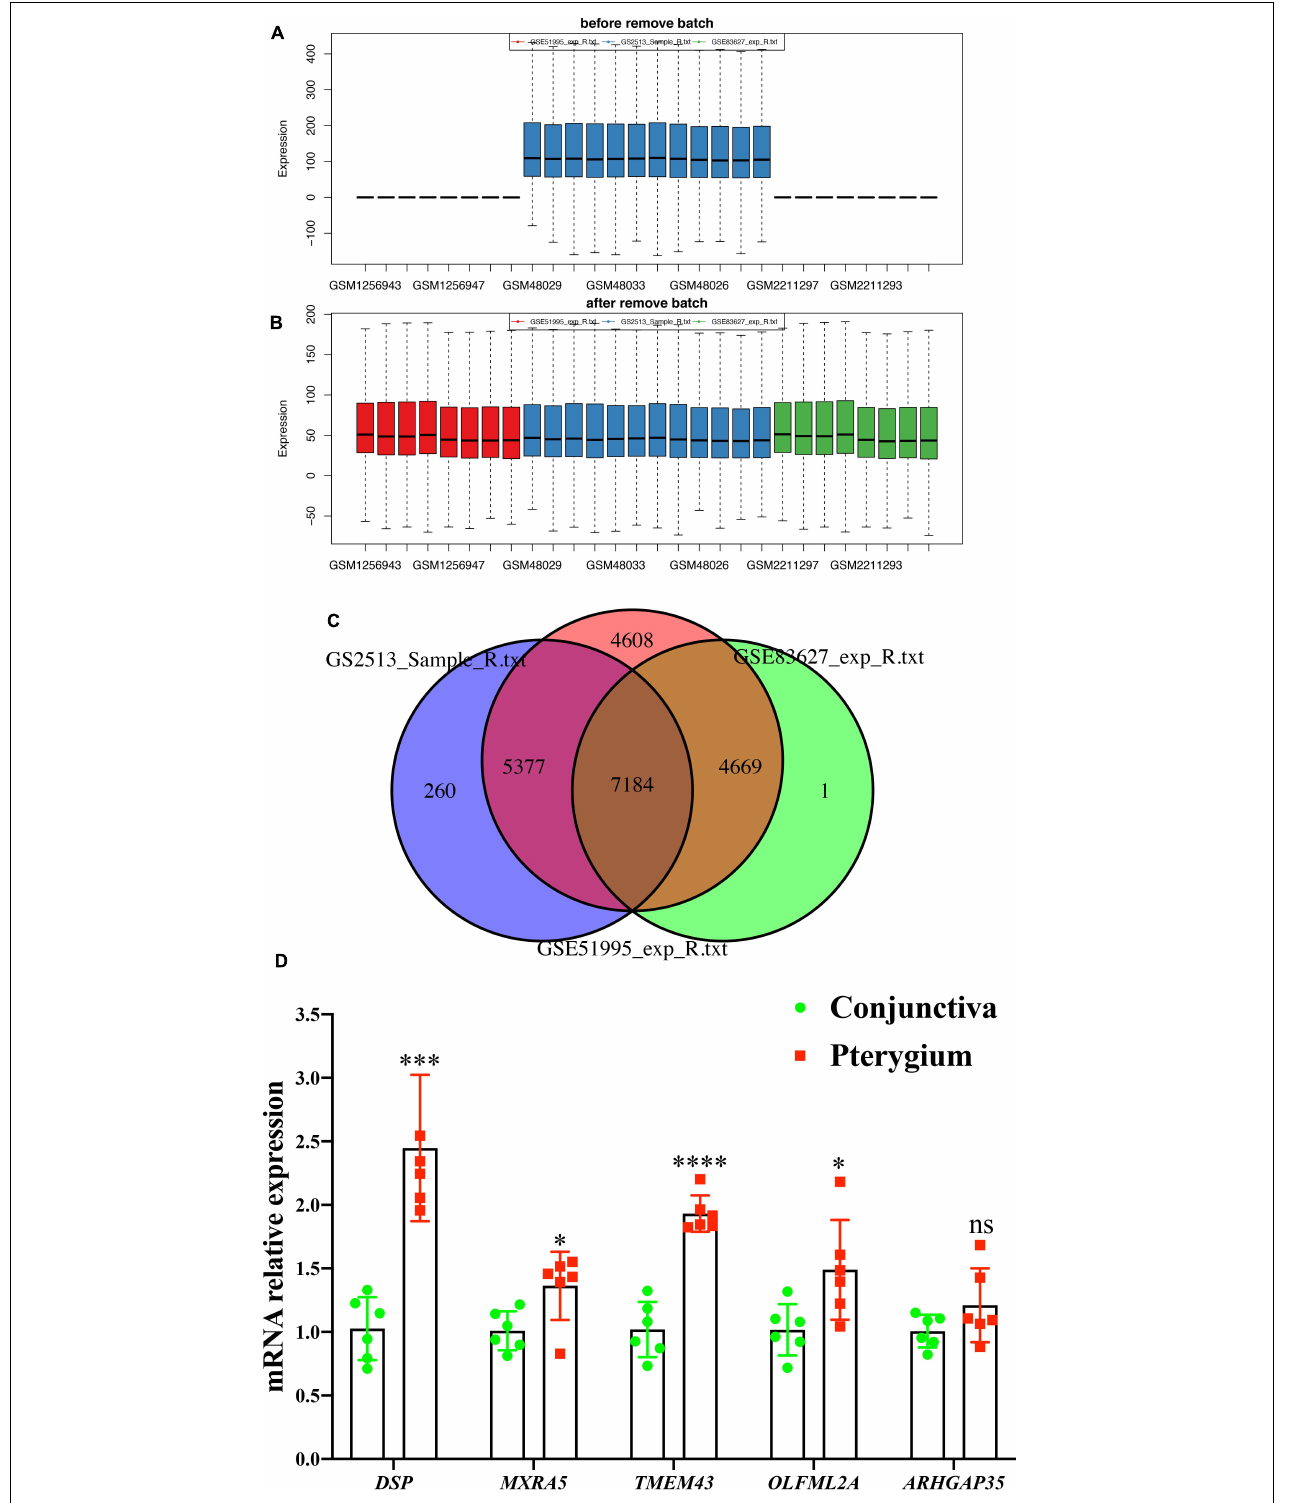
FIGURE 8 | Validation gene expression in GEO datasets. (A,B) The expression of genes from GEO datasets (GSE2513, GSE51995, and GSE83627) were normalized to remove batch effects. (C) Wayne chart of the three GEO datasets. (D) mRNA expression level of five hub genes ( DSP , MXRA5 , TMEM43 , OLFML2A , and ARHGAP35 ) determined via qPCR. N = 6 per group. Results are expressed as the mean ± SEM (NS indicates not significant, * P < 0.05, ** P < 0.01, *** P < 0.001, **** P < 0.0001 compared to the conjunctiva group).